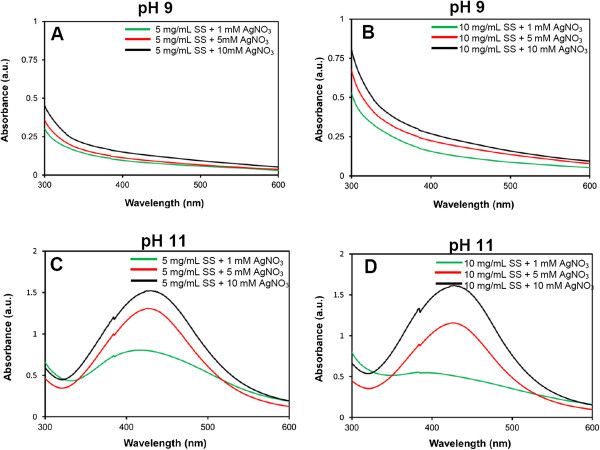
Formation of SS-capped AgNPs at pH 9 and 11. (A) 5 mg/mL SS + 1, 5, 10 mM AgNO3 at pH 9, (B) 10 mg/mL SS + 1, 5, 10 mM AgNO3 at pH 9, (C) 5 mg/mL SS + 1, 5, 10 mM AgNO3 at pH 11, (D) 10 mg/mL SS + 1, 5, 10 mM AgNO3 at pH 11.